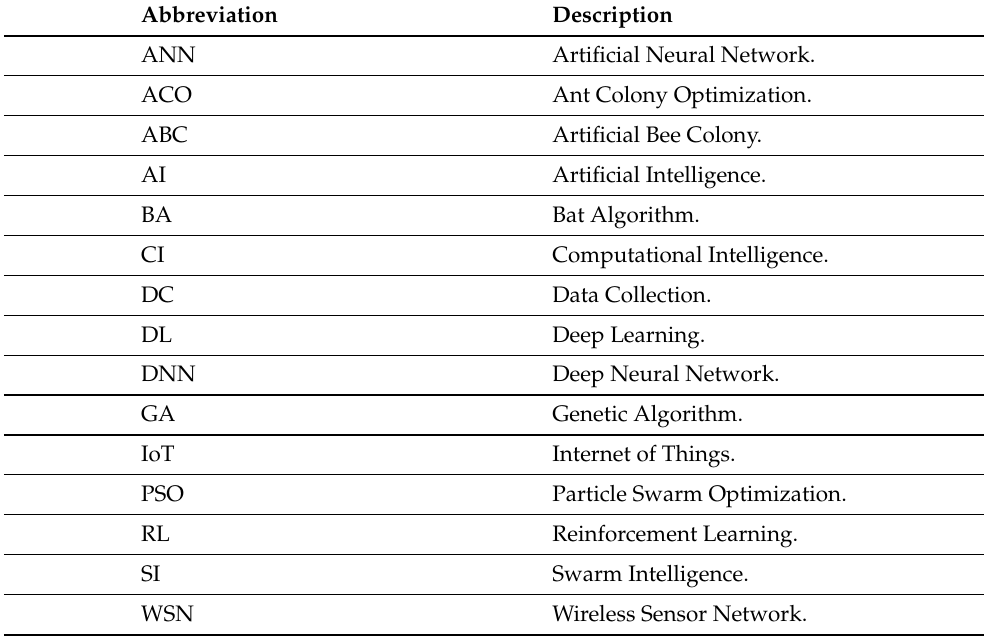
Table 1. Table of main